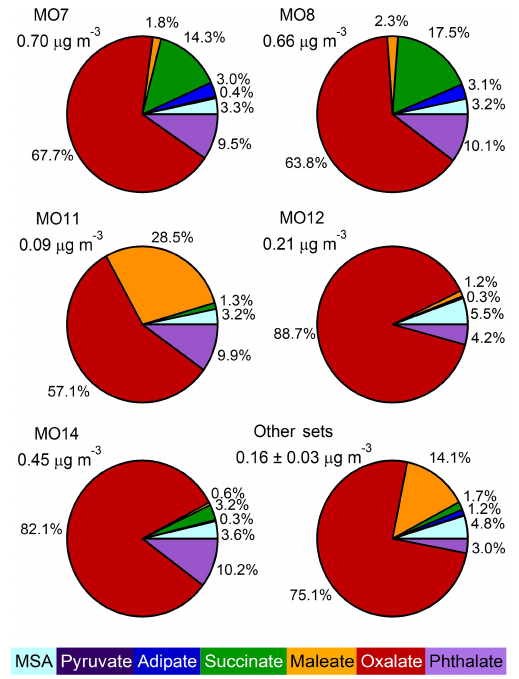
Figure 8. Pie charts showing the fraction of species contributing to the measured water-soluble organic aerosol. Below each pie chart title is the sum of the water-soluble organic species measured, with the “other sets” chart showing the average ± 1 standard deviation for the remaining